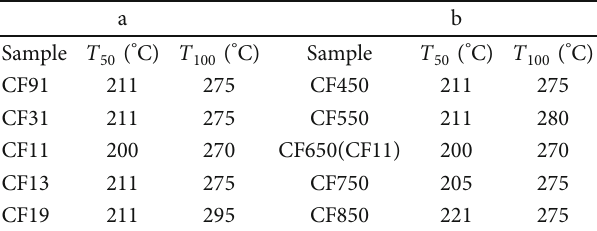
T Table 3: T 50 and 100 temperatures of CeO 2 -Fe 2 O 3